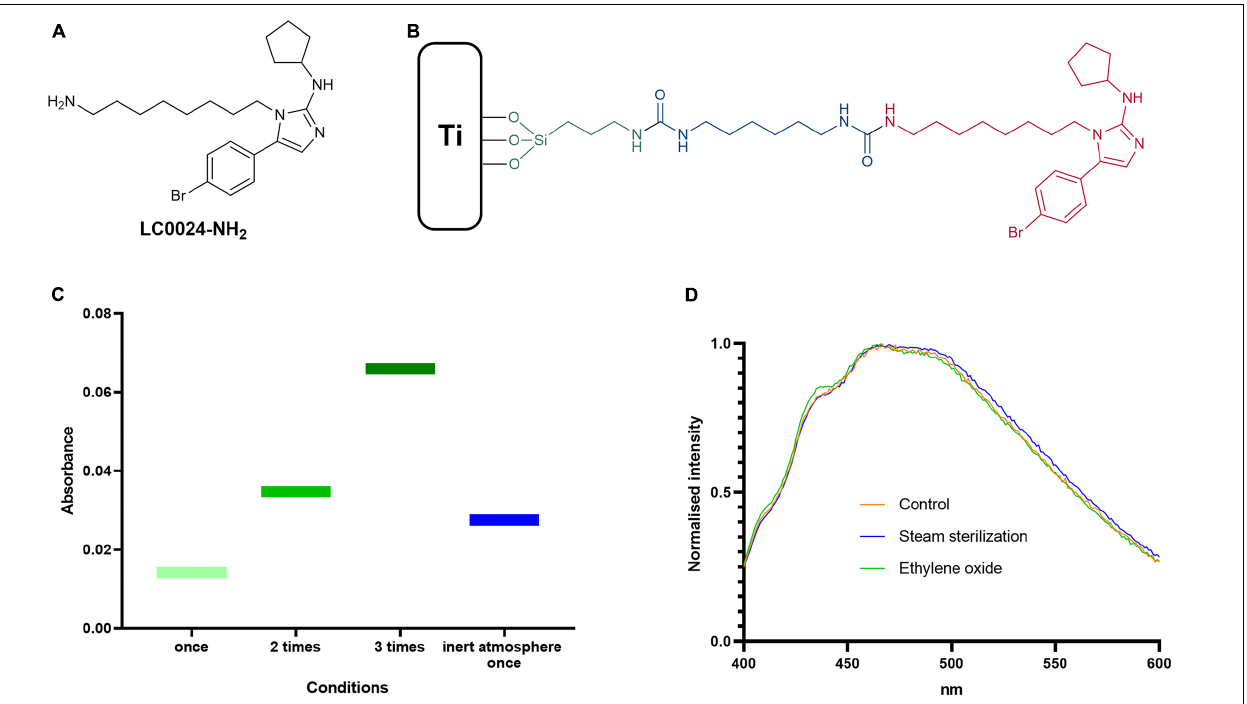
FIGURE 1 | Optimized coating and chemical analyses. (A) Schematic structure of LC0024-NH 2 ; (B) schematic representation of the coating sub-units; (C) results from the silanization step optimization; and (D) fluorescence emission profiles of the sterilized samples compared to the control